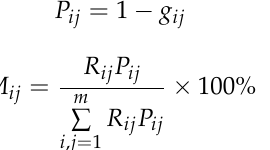
Table 3. Evaluation criteria of ecological security. Range Status Characteristics The pressure on the ecosystem is very large, the ecosystem [0, 0.25) Critical structure is very imperfect, and the ecosystem has a very large risk of collapse. The pressure on the ecosystem is large; the ecosystem [0.25, 0.45) Unstable structure has defects and is in an unstable state. The pressure on the ecosystem is large and close to the [0.45, 0.55) Sensitive threshold; the ecosystem structure is relatively complete and can play the basic function of the ecosystem. The ecosystem has relatively little pressure and perfect Good functions, and the ecosystem is in a relatively stable state. Secure ecosystem is in a very stable